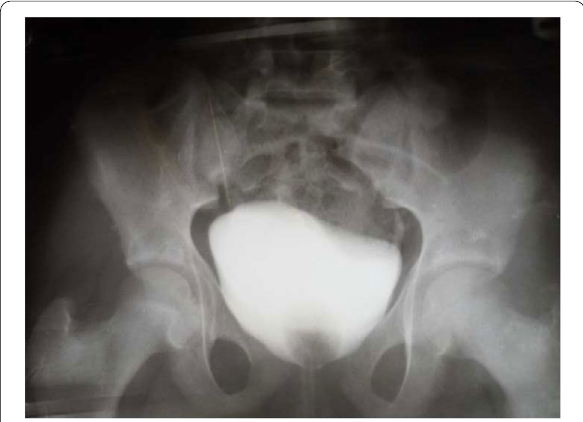
Fig. 2 Micturating